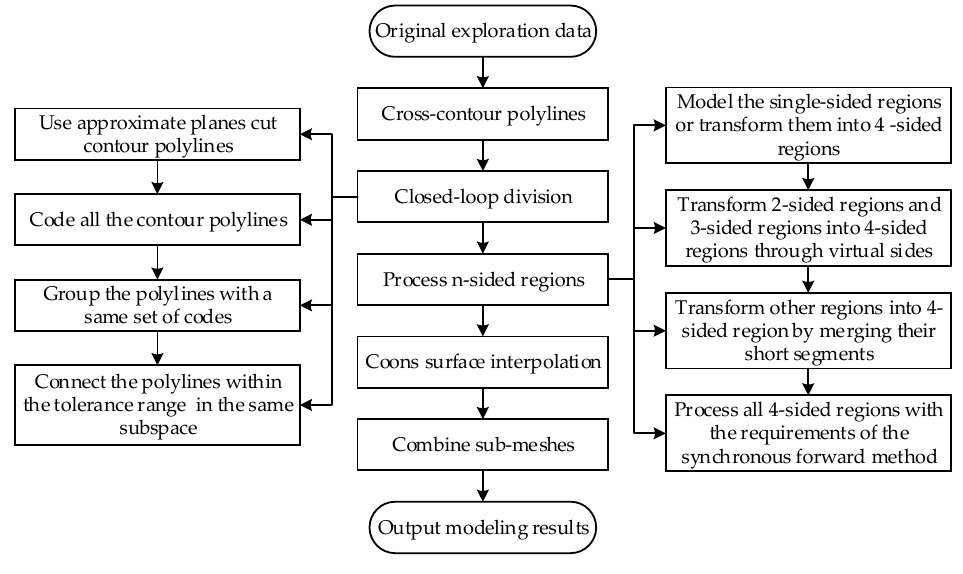
Figure 1. Overall flow chart .